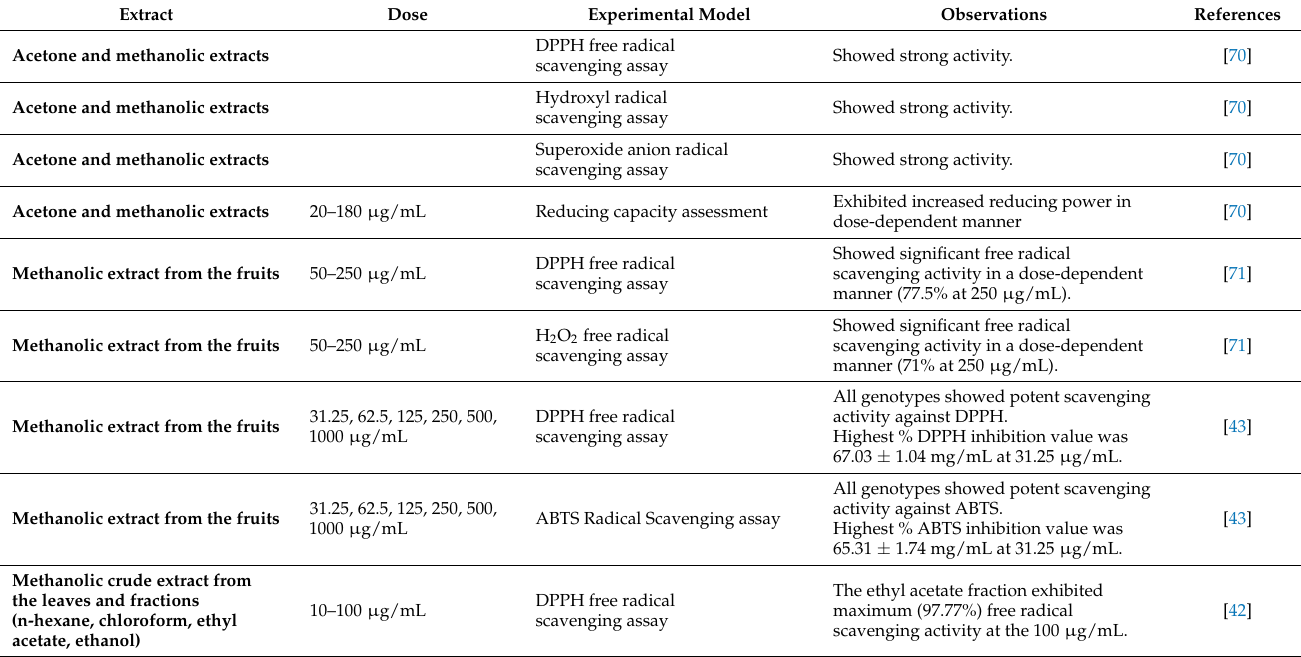
Table 5. The antioxidant effects of Ziziphus nummularia